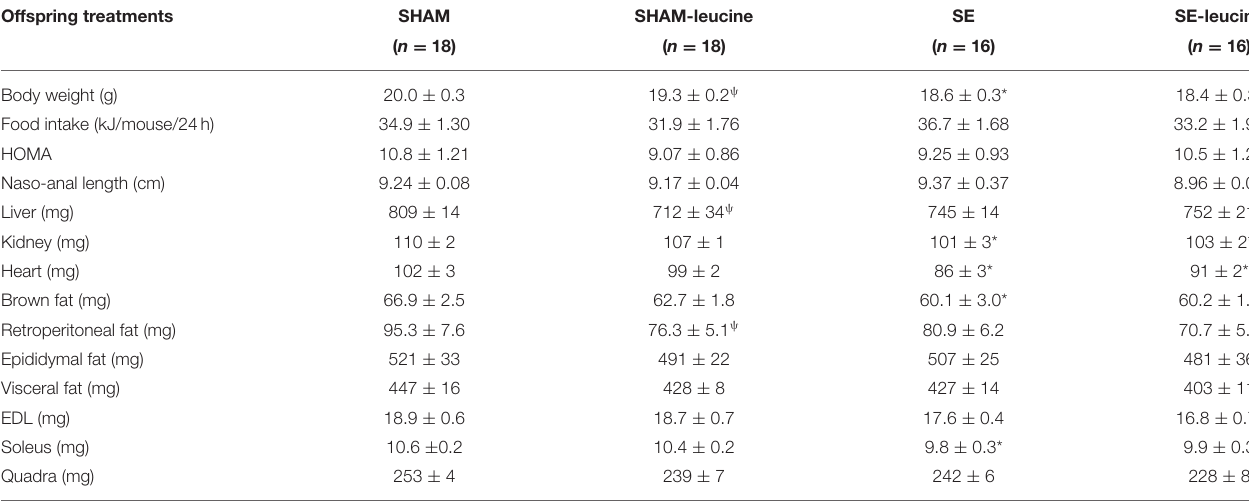
TABLE 1 | Effects of maternal se and postnatal leucine supplement in female offspring. Offspring treatments SHAM